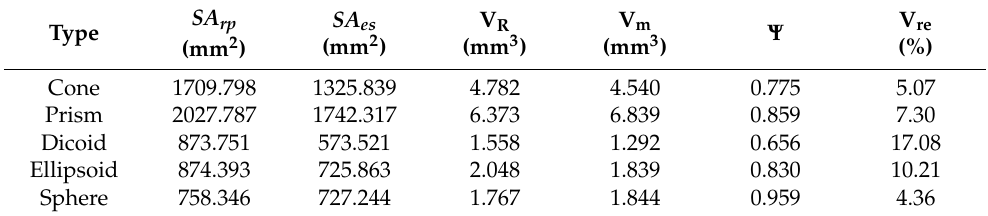
Table 3. Model parameters for different fill levels.